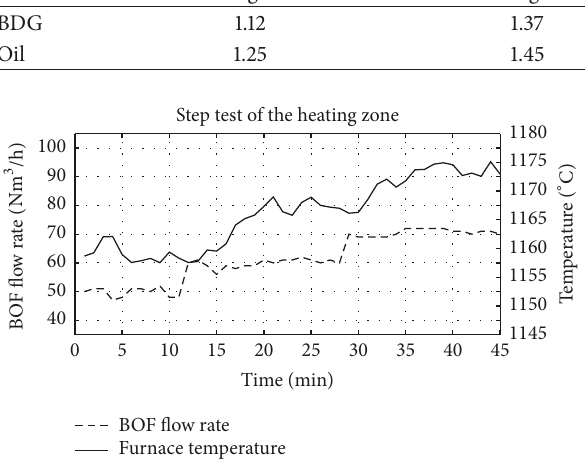
Table 2: Mean absolute error of 1st-order model for BDG and oil. Homog. zone